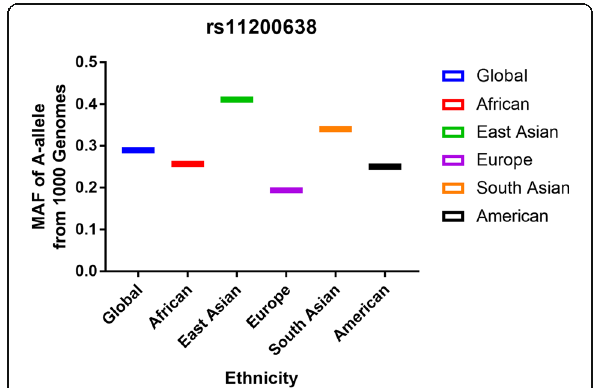
Fig. 3 Frequency about A-allele for the rs11200638 polymorphism among cases or controls by